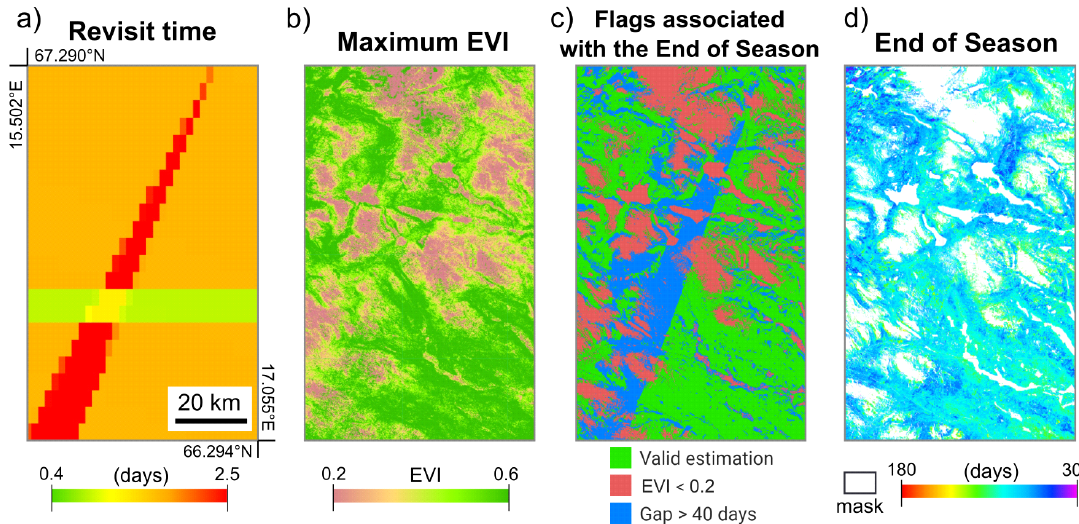
Figure 7. Example of flags associated with gaps in the Sentinel-2 time series in the Scandinavian mountains. ( a ) Revisit time; ( b ) maximum enhanced vegetation index (EVI) for 2019; ( c ) flags raised during the estimation of end-of-season (EoS); ( d ) EoS estimation. Red: non-vegetated pixels (EVI < 0.2); blue: pixels with > 40-d gap in time series; EoS was extracted with the 50% threshold method applied to the non-smoothed Sentinel-2 EVI time series.